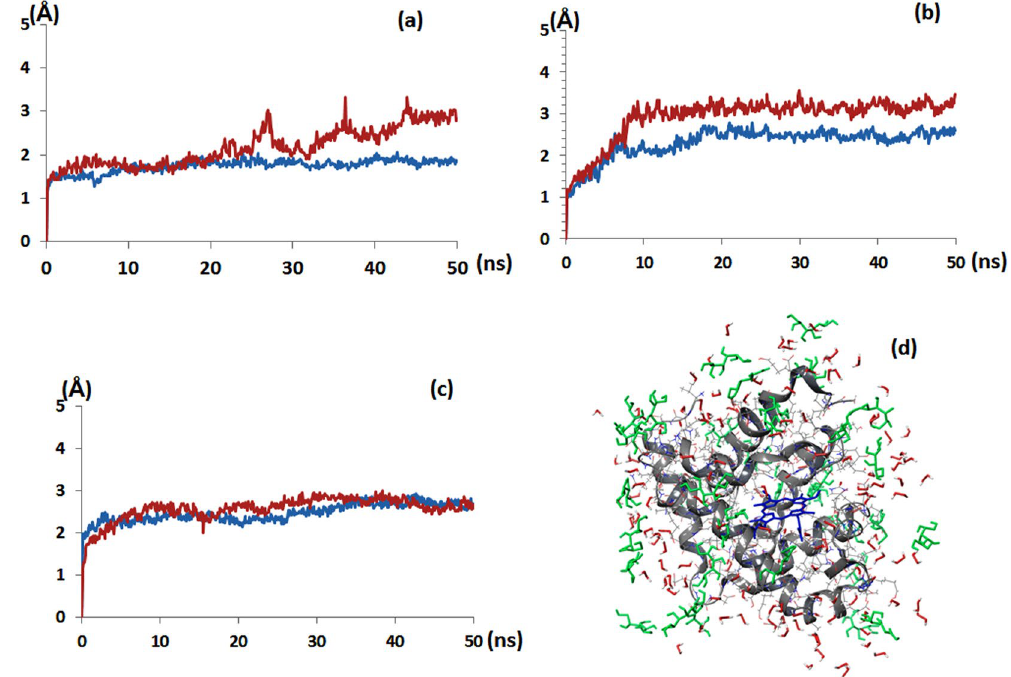
Figure 7. Molecular dynamics simulation result of Myoglobin, ( a ) RMSD plots of the Myoglobin in the phosphate buffer and 21% H 2 O 2 ; ( b ) RMSD plots of the Myoglobin in the phosphate buffer, 21% H 2 O 2 + 21% sorbitol; ( c ) RMSD plots of the Myoglobin in the phosphate buffer, 21% H 2 O 2 + 21% trehalose; ( d ) Snapshot of Myoglobin with 21% sorbitol + 21% H 2 O 2 (Gray ribbon and wire - myoglobin, Blue - heme group, Green - sorbitol and Red - H 2 O 2 ).